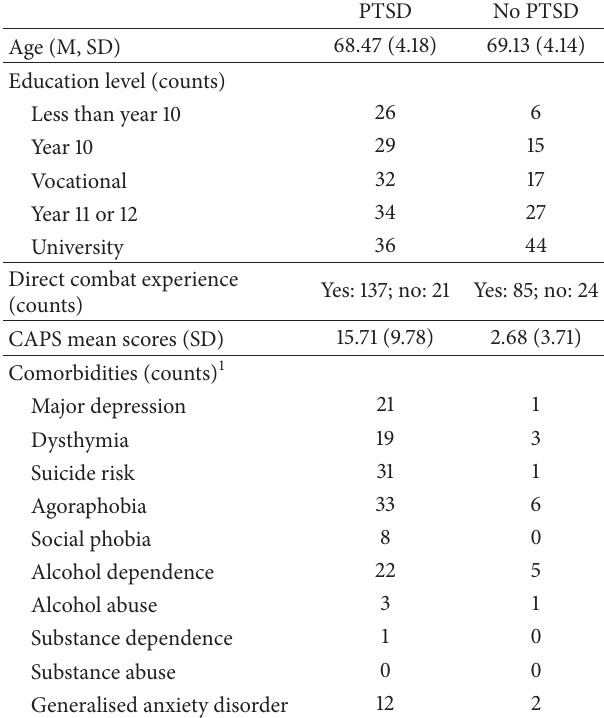
Table 2: Demographics and clinical